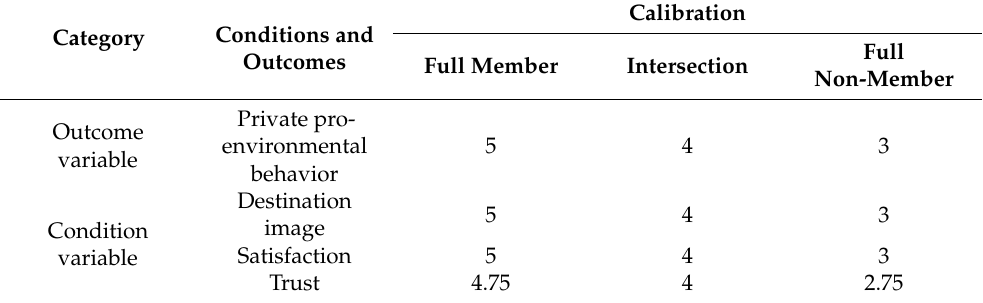
Table 9. Calibration of conditions and outcomes in the private pro-environmental behavioral model.